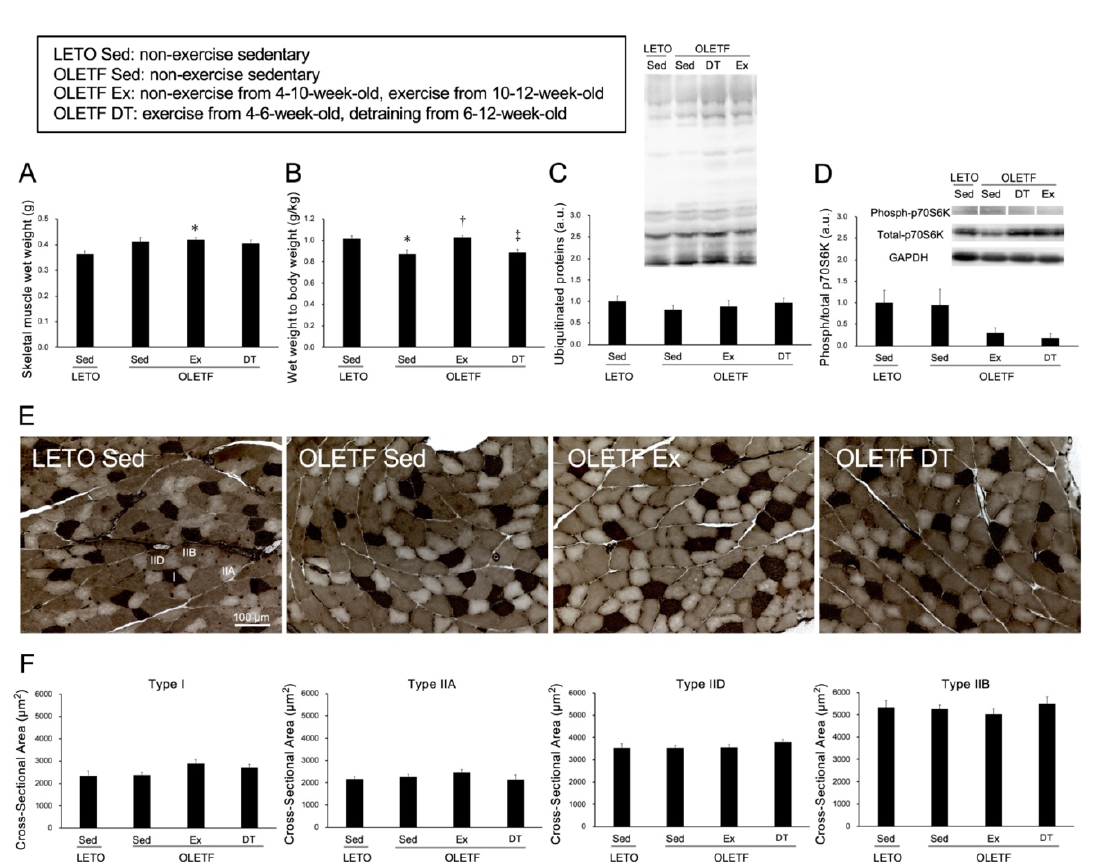
Figure 2. Histological influences of exercise on the skeletal muscle. ( A ) wet weight of the skeletal muscle; ( B ) the ratio of muscle wet weight to body weight; ( C ) expression level of ubiquitinated proteins; ( D ) phosphorylation of p70S6K; ( E ) representative sections of skeletal muscle stained with adenosine triphosphatase (ATPase) (pH 4.6); ( F ) cross-sectional area of type I, IIA, IID, and type IIB fibers. I: type I fiber; IIA: type IIA fiber; IID: type IID fiber; IIB: type IIB fiber. Values represent means ± standard deviation. For the expression level of protein ( C , D ) values are calculated as the fold changes relative to the LETO Sed group. *, †, and ‡ show significantly different from the LETO Sed, OLETF Sed, and OLETF Ex groups, respectively, p < 0.05.